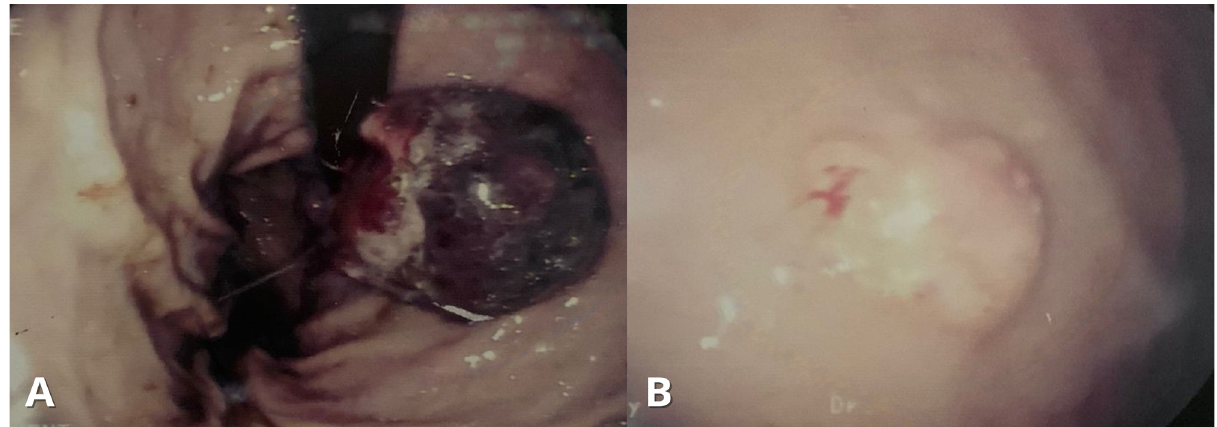
Figure 1. Gastric lesions at the upper gastrointestinal endoscopy. A. Polypoid lesion with a diameter of approximately 5cm in the gastric body; B. Ulcerative-infiltrative gastric lesion in the lesser curvature, with approximately 2cm in diameter and an area of necrosis on the